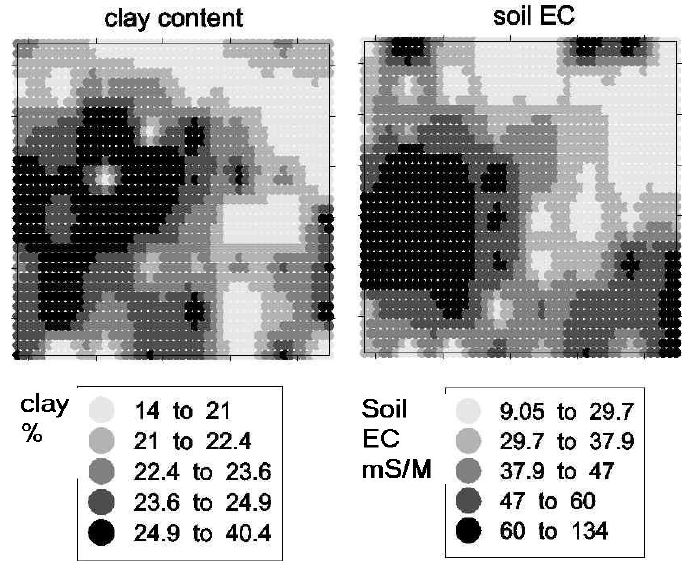
FIGURE 5. Clay content and soil conductivity from a 16-ha Iowa field.